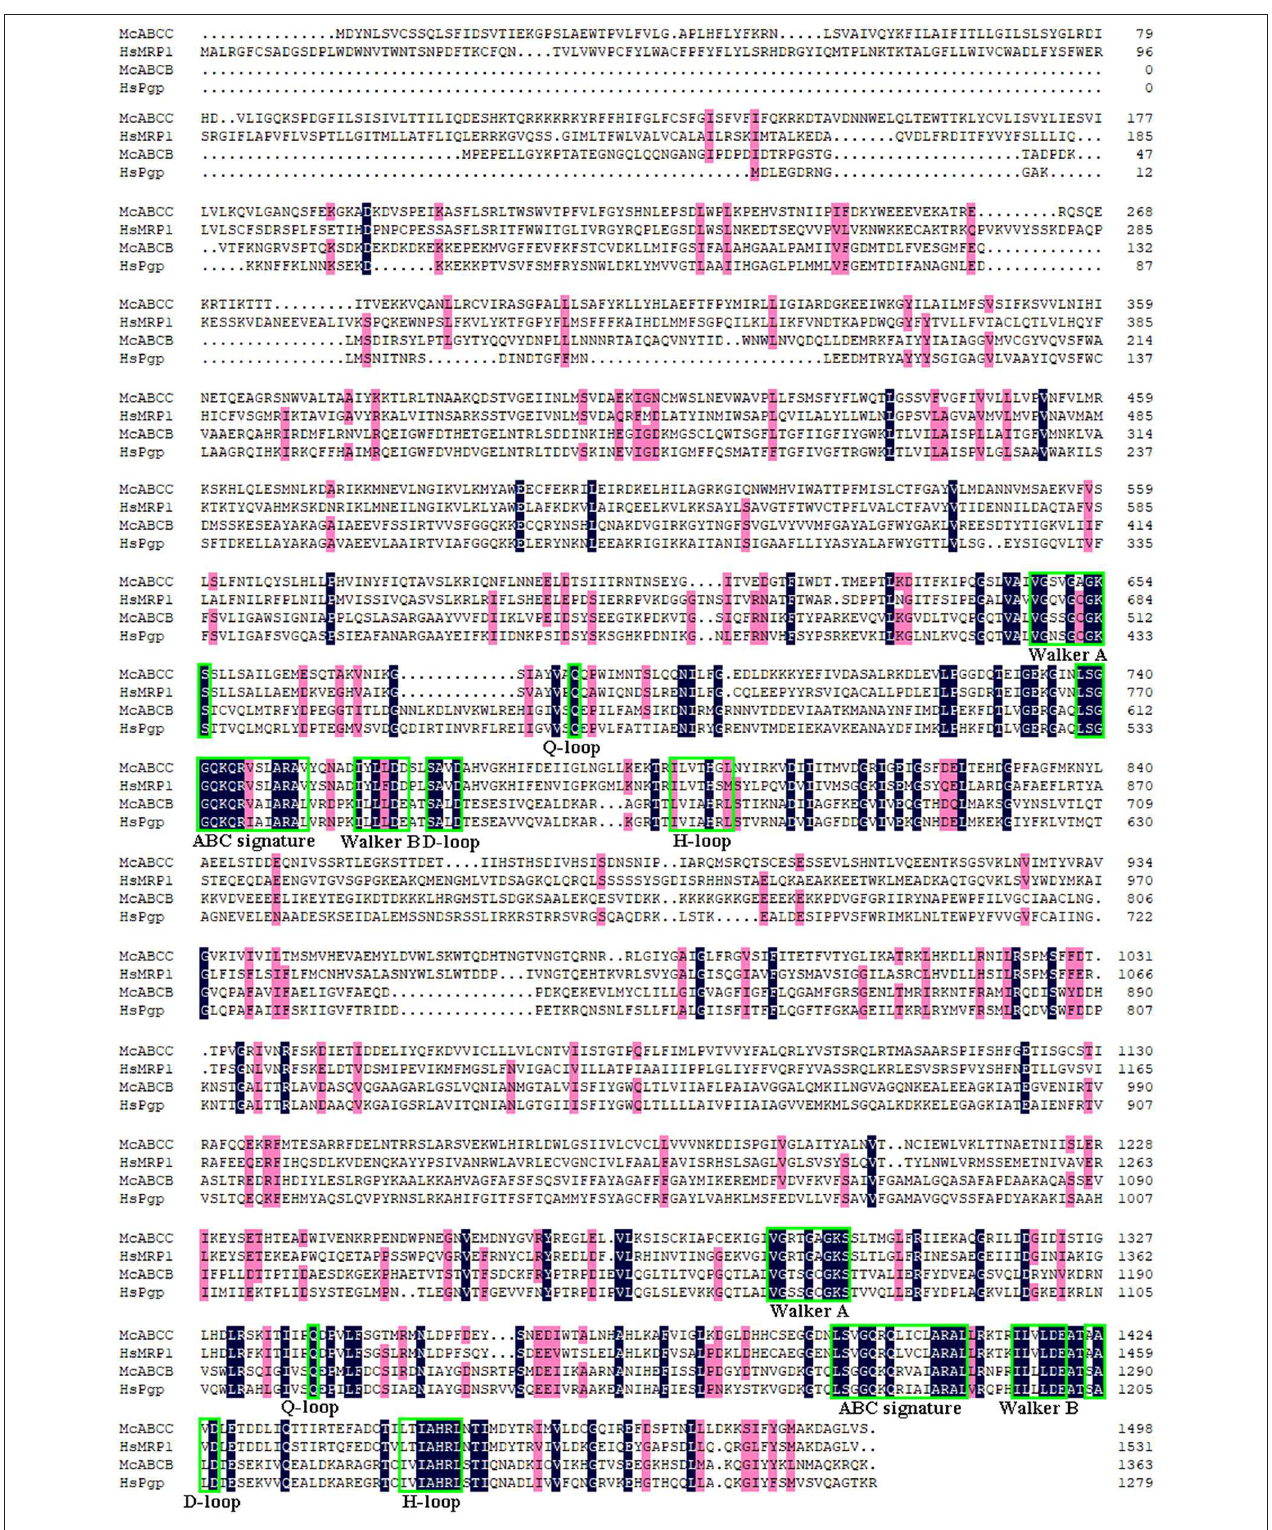
FIGURE 2 | Alignments of Mco ABCB1 and Mco ABCC with their correspondents from human ( Hs ABCB1, GenBank accession no. AAI30425.1 and Hs ABCC, GenBank accession no. ABD72213.1). Identical amino acid residues are represented by dark blue color, while pink color indicates the similarity surpass 75 %. The nucleotide-binding Walker A and B motifs, ABC signature motifs, D-, H- and Q-loops in the sequences are denoted by green rectangle (For interpretation of the references to color in this figure legend, the reader is referred to the web version of this article).